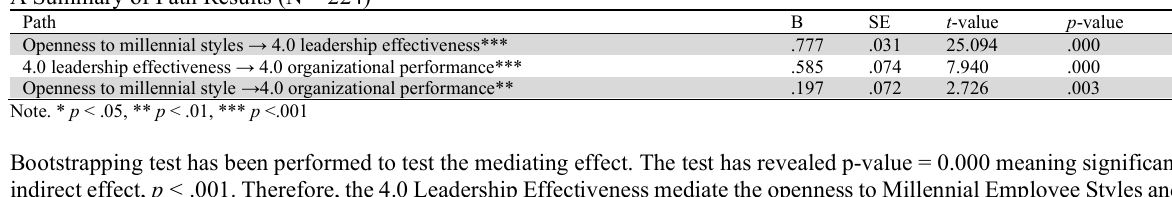
Table 4 presents the path coefficients of the structural model. Overall, H 1 was supported with positive path coefficient at the .001 nominal significance level. Hence, the structural equation modeling confirmed that openness to millennial employee style is a significant antecedent of 4.0 leadership effectiveness (β = .78, p < .001). At the same time, the openness to millennial